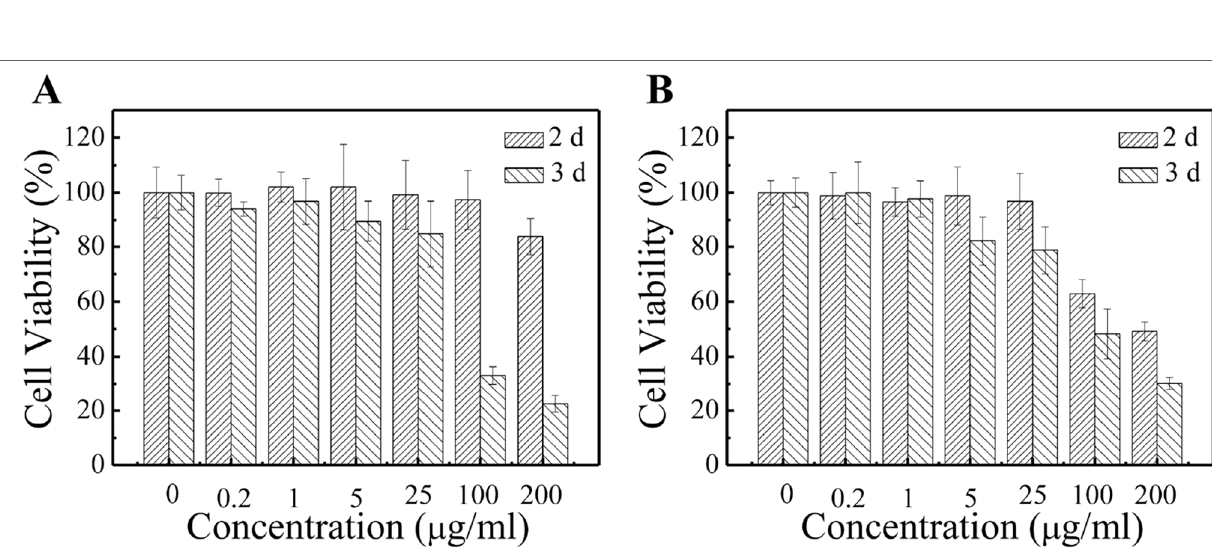
FIGURE 6 | Cytotoxicity tests of PCL-PDEM/QD formulation by MTS assays. (A) Sk-Hep1 cells and (B) L929 cells.